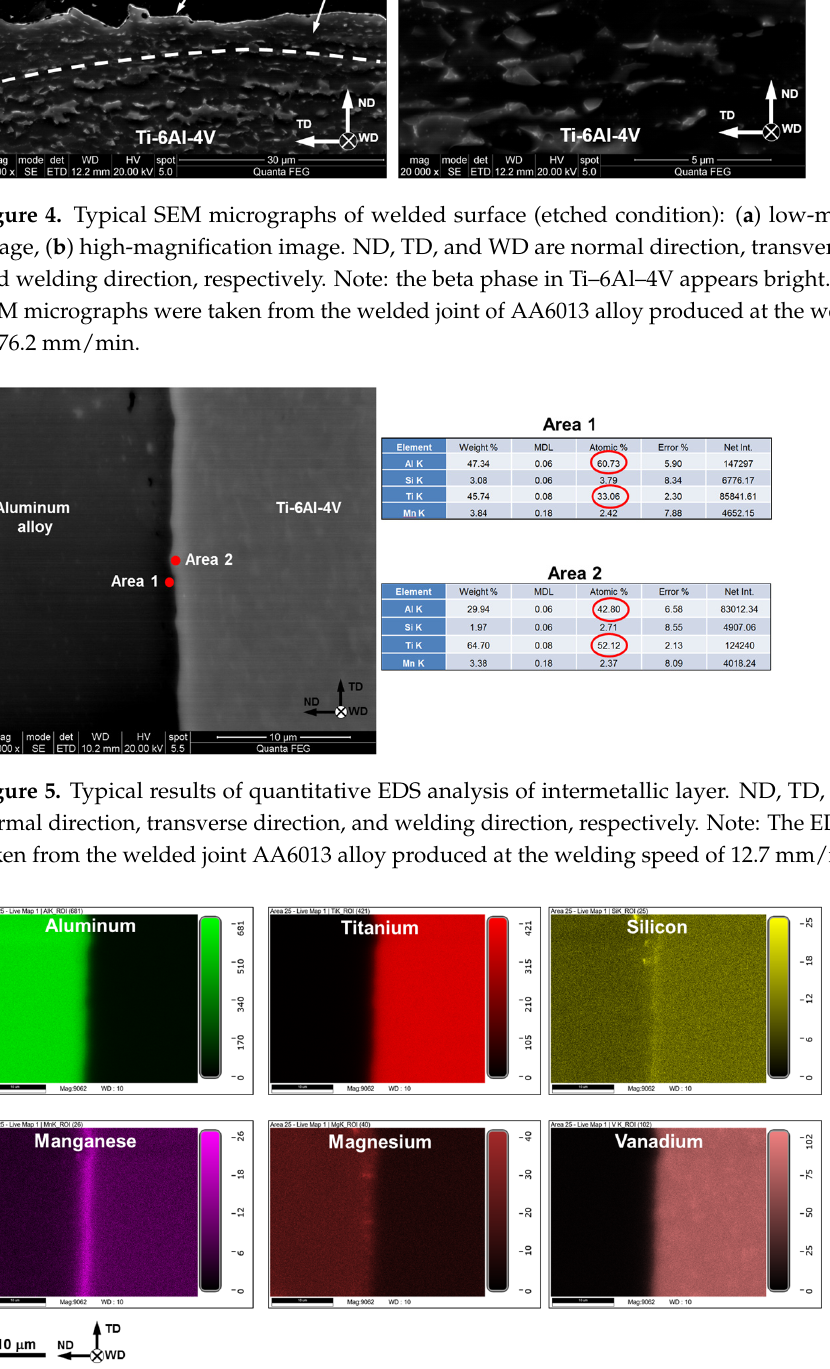
Figure 6. Typical EDS maps showing elemental distribution across the welded surface. In all cases, aluminum side is on the left and Ti–6Al–4V side is on the right. ND, TD, and WD are normal direction, transverse direction, and welding direction, respectively. Note: The EDS data were taken from the welded joint of AA6013 alloy produced at the welding speed of 76.2 mm/min.